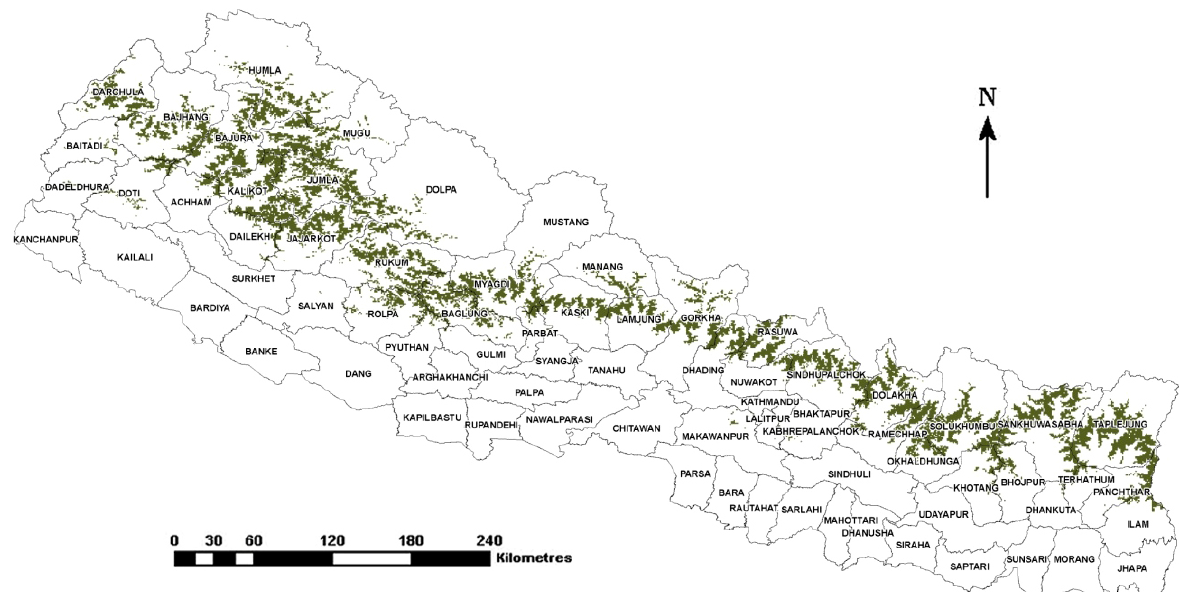
Figure 3. The extent of the preferred habitat of Ailurus fulgens in Nepal (dark green areas) (MoFSC